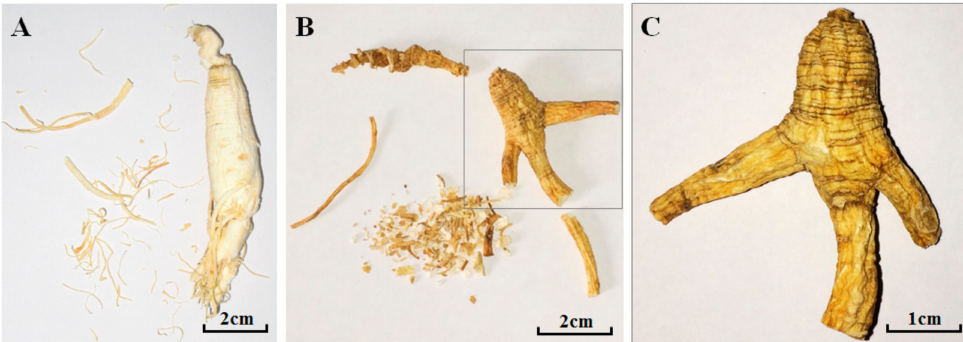
Figure 8. Photographs of cultivated ginseng (( A ), no. 21, 6-year-old) and ginseng under forest (( B ) no. 27, 9-year-old) and its amplified main root part with dark yellow color and deep cross striation (( C ) no.